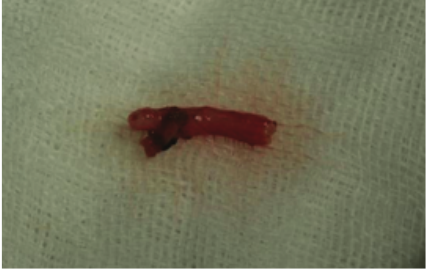
Figure 2: Cut off the gastroduodenal artery as a bridge for hepatic artery reconstruction.